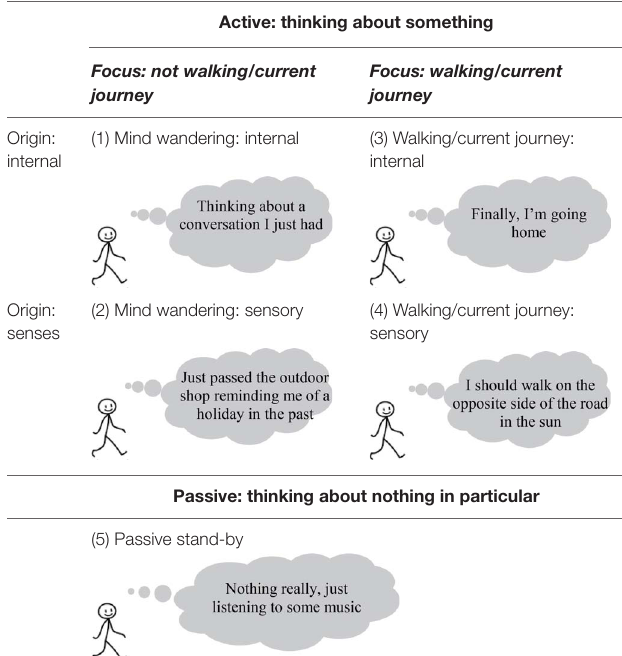
TABLE 1 | Five-way categorization of pedestrians’ thoughts, adapted from Burdett et al.